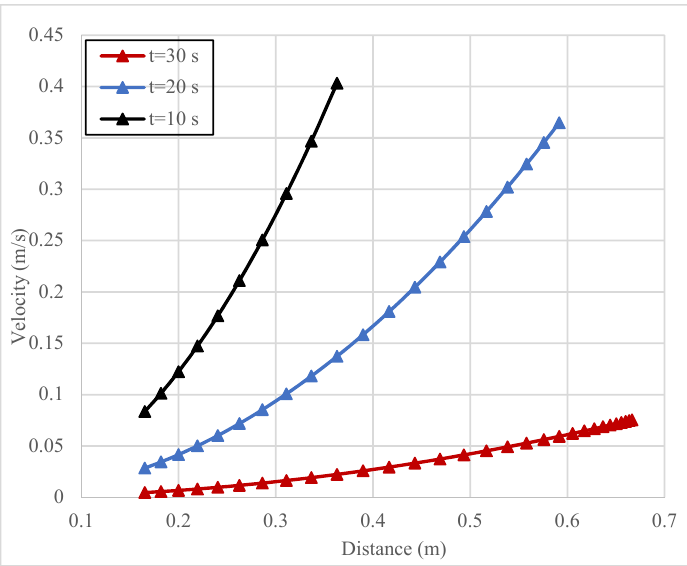
Figure 17. Variation curve of slurry velocity with radial distance at different time.